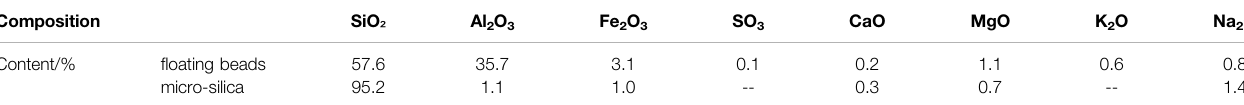
TABLE 2 | Chemical composition and percentage of the fl oating beads and micro-silica. Composition